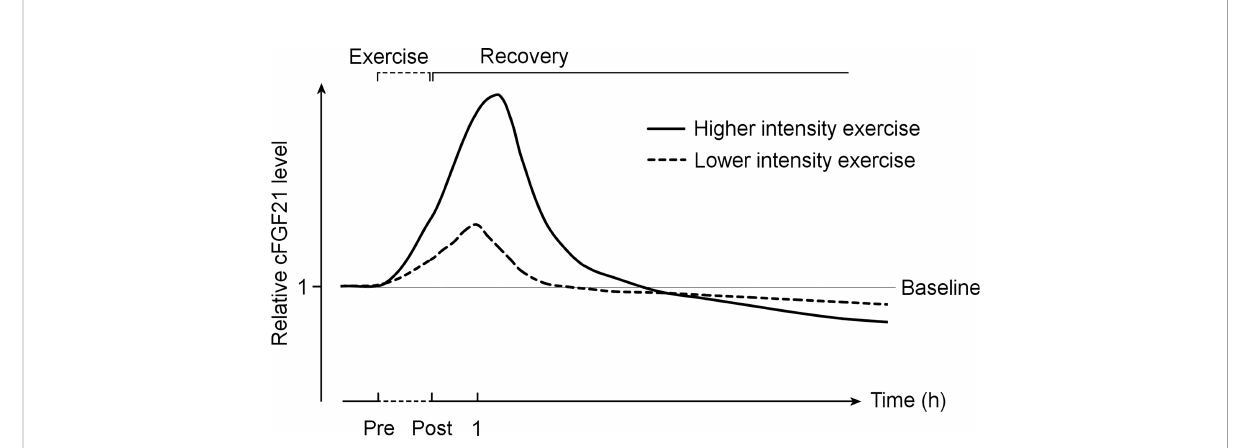
FIGURE 9 The exercise-induced cFGF21 level changes over time and with different exercise intensities. The fi gure includes two curves depicting changes in relative cFGF21 levels in subjects undergoing relatively higher- and lower-intensity exercises during the pre-exercise (Pre) and post-exercise (Post) periods. cFGF21, circulating fi broblast growth factor